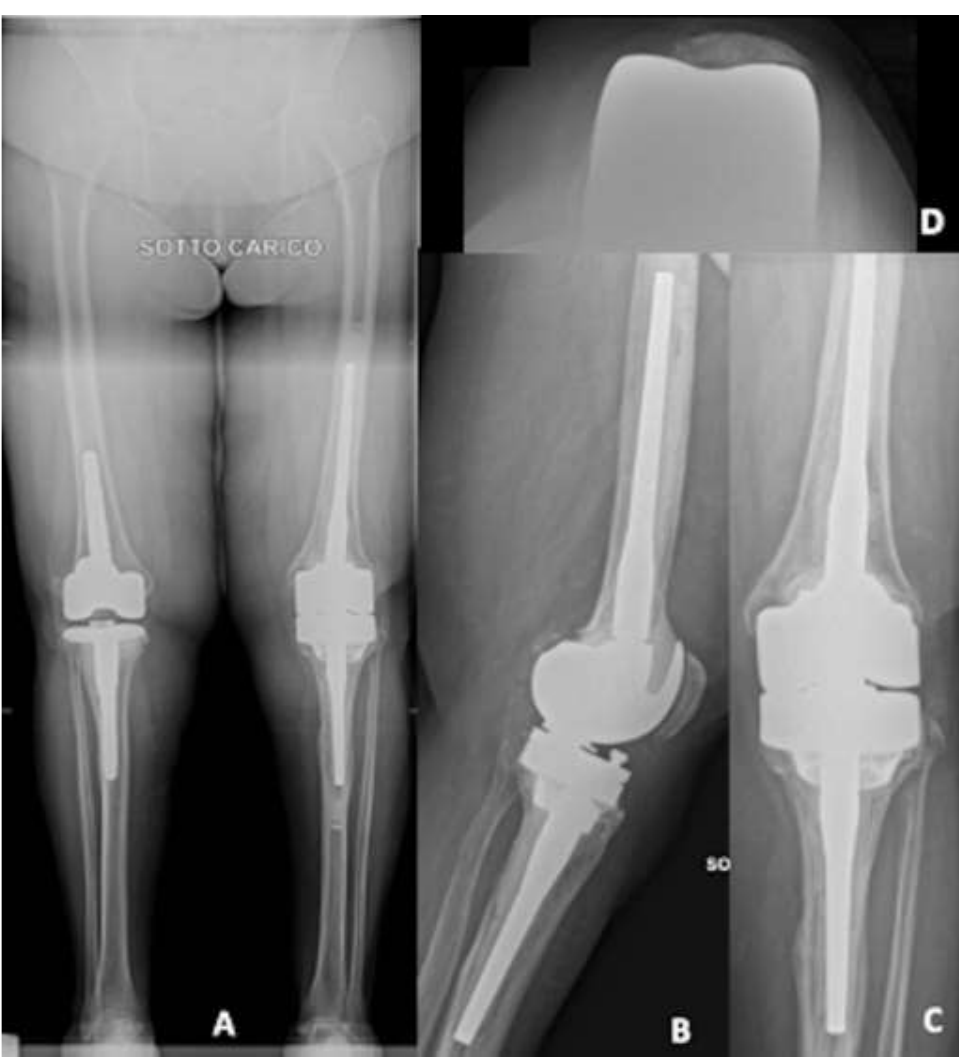
Figure 10. X-rays one year after surgery. ( A ) Long-leg weight bearing view; ( B ) lateral view; ( C ) antero-posterior view, ( D ) patellar view.